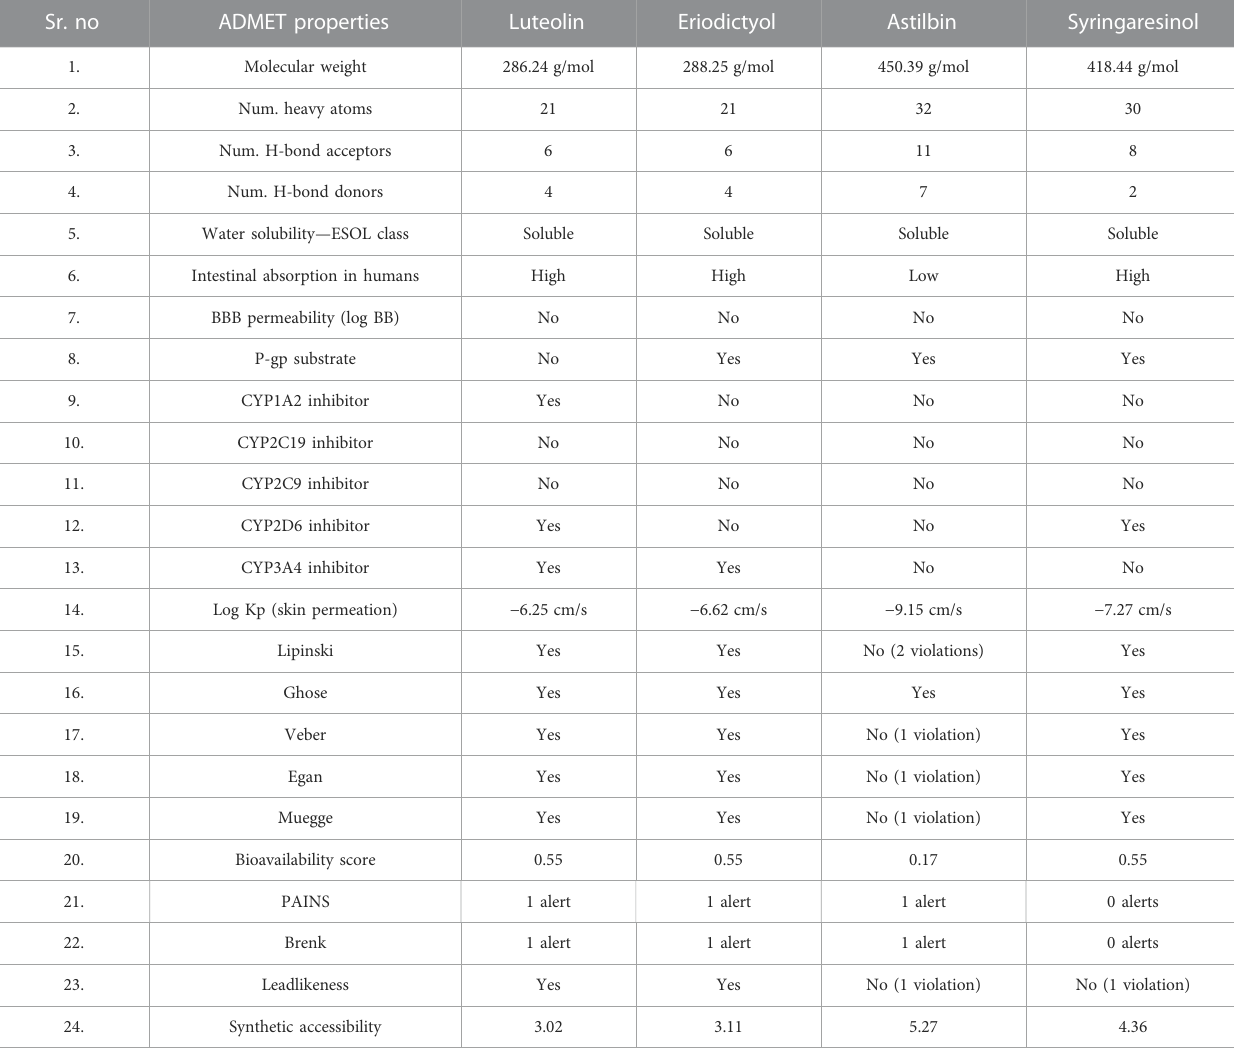
TABLE 5 In silico pharmacokinetics, physico-chemical and ADMET properties, and drug-likeness of ligands. Sr.